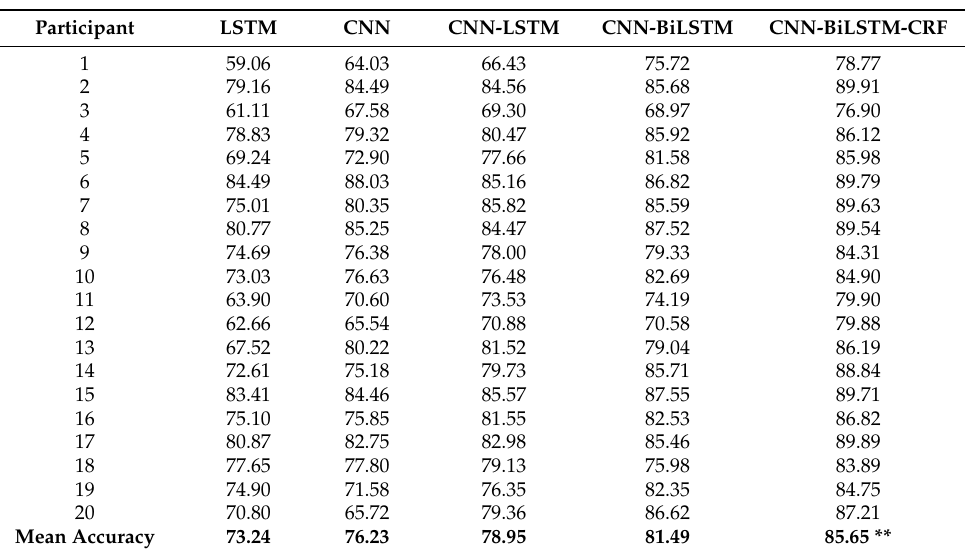
Table 3. Mean classification accuracy with a 10-fold cross-validation technique for each participant in Experiment 1. Ten test runs were performed on each model, and the average of the results was